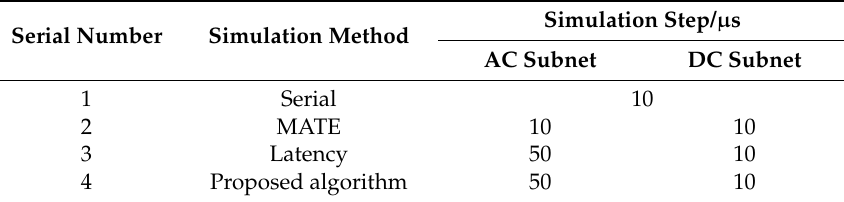
Table 2. Setting of the simulation step.